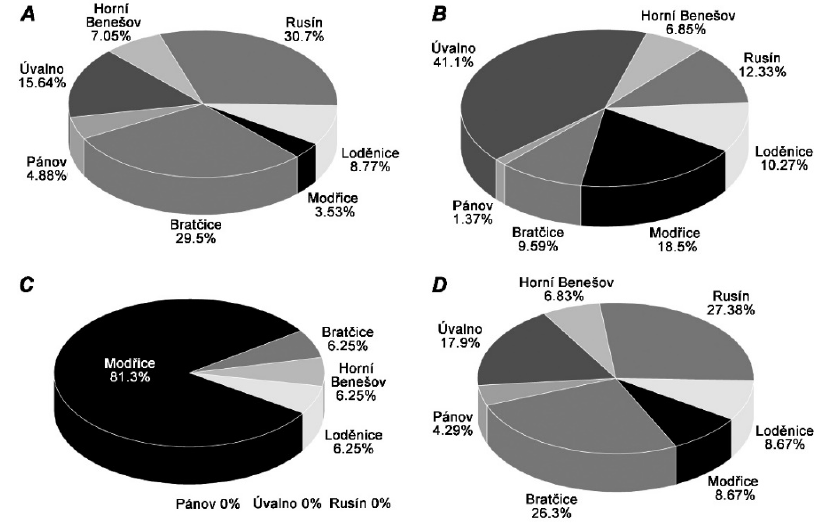
Figure 4. The most widespread genera of methanogenic microorganisms in the anaerobic digesters: Methanoculleus ( A ), Thermogymnomonas ( B ), Methanobacterium ( C ), total number ( D ).